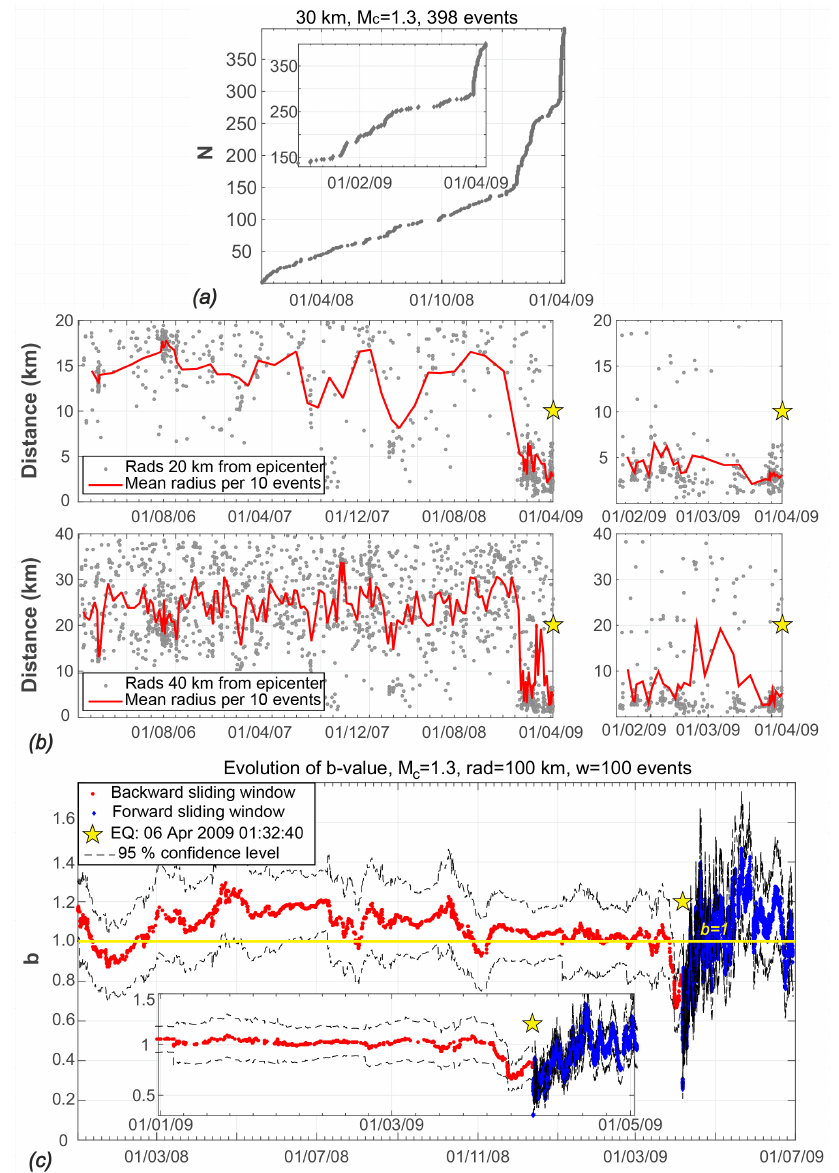
Figure 2. Time–space–size evolution of the L’Aquila foreshock sequence based on the INGV earthquake catalog. (a) Cumulative number of earthquake events within a circle of radius of 30km from the mainshock epicenter. The dramatic increase in the seismicity rate in about the last 3 months and particularly in the last 10 days (significance level 99%) before the mainshock of 6 April 2009 is evident. (b) Time evolution of the mean distance (red line) of foreshock epicenters from the mainshock epicenter (yellow star) for a radius of 40km (upper panel) and 20km (lower panel). Calculation has been made for sequential but not overlapping sets of 10 events. The yellow star indicates the mainshock origin time. The mean distance gradually decreased, being minimal in the last 10 days, that is, during the strong foreshock stage. The right panels of the figure represent a zoomed area of the left ones showing the time evolution of the mean distance of foreshock epicenters from the mainshock epicenter for the last 2 months. (c) Time evolution of the parameter b calculated backwards before the L’Aquila mainshock (red) and forwards after the mainshock (blue). The parameter b was calculated for sequential segments of the catalog with a constant number of n = 100 events and a step of 1 event under the condition that the magnitude range in each segment was at least 1.4, as suggested by Papazachos (1975). The aim was to achieve stability in the results. If this condition was not satisfied, then n was increased gradually with a step of one event until the condition was satisfied. Black lines represent ± 2 σ confidence intervals. Yellow star as in Fig. 2b. The parameter b dropped gradually and reached values of less than 0.70 in the last 10 days before the mainshock. In the aftershock period the b value increased rapidly above 1. The yellow line in b = 1 makes the differences for different time windows more